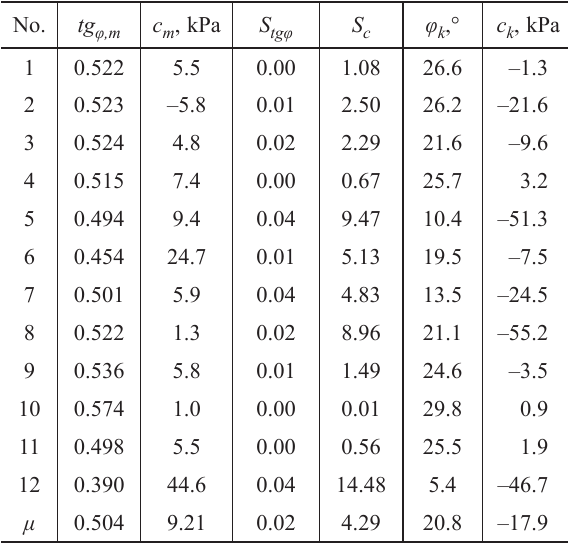
Table. 1. Processed soil shear parameters of strength